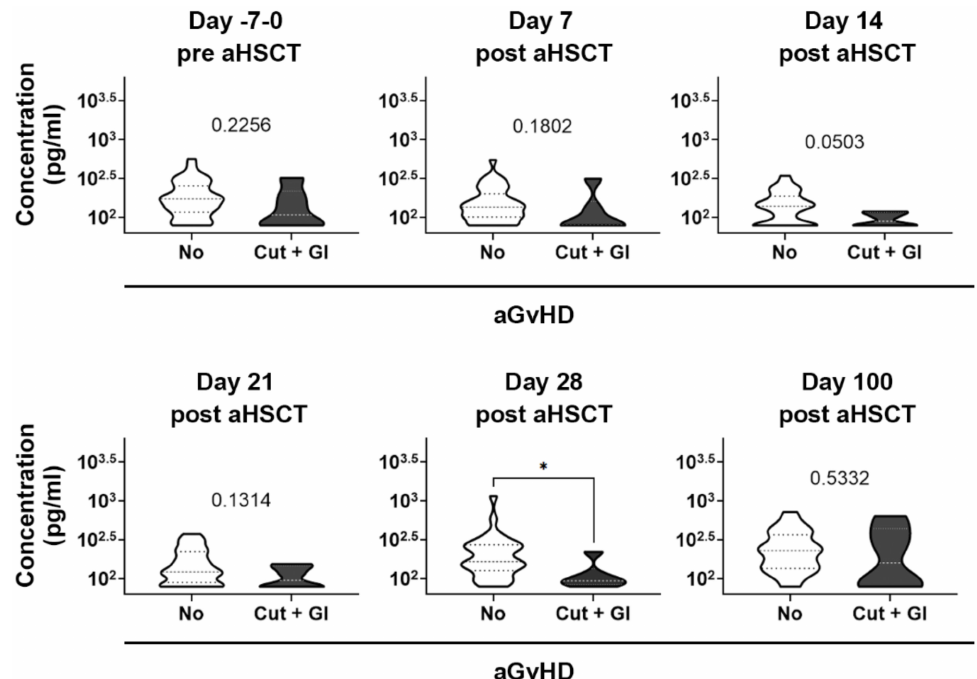
Figure 5. Follow-up analysis of the kinetic changes of plasma KRT20 concentration at various time points pre- and post aHSCT: a focused analysis comparing completely unaffected (No aGVHD) and severely affected (Cut + GI aGVHD) aHSCT patients ( t -test: * p <